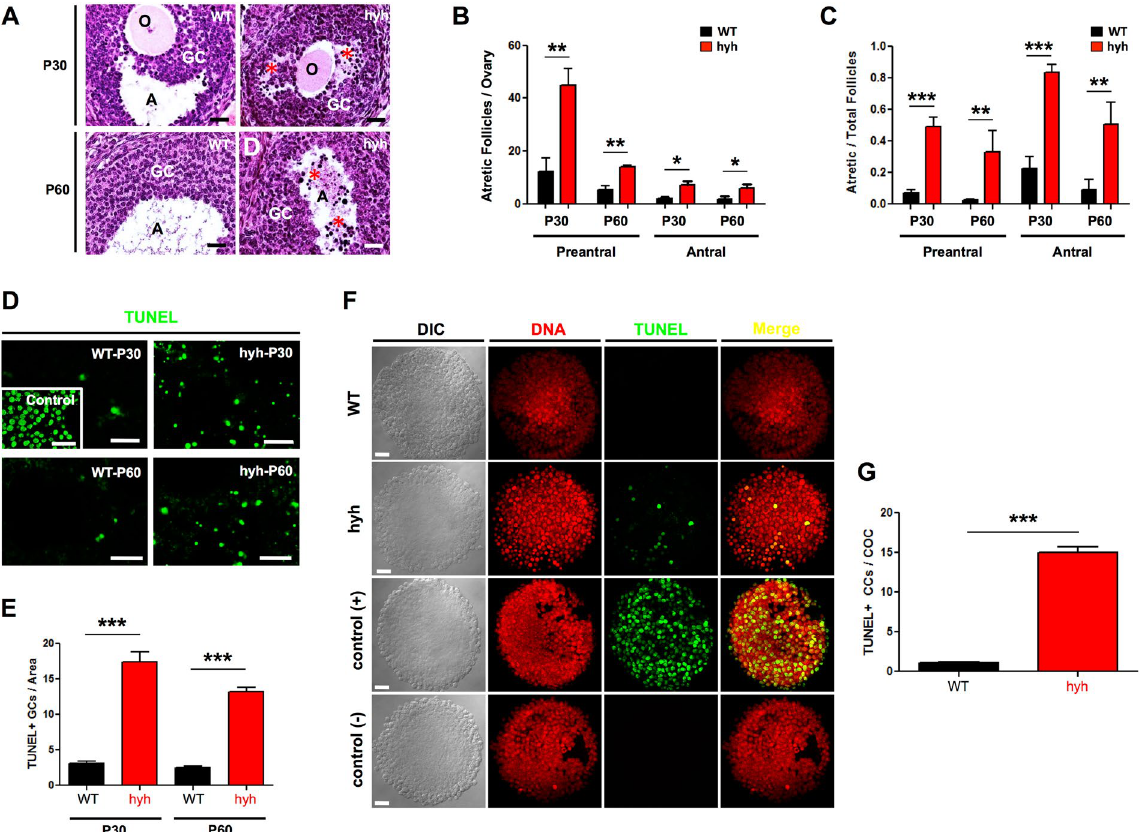
Figure 4. Follicular atresia and apoptosis of granulosa cells (GCs) in α -SNAP mutant (hyh) ovaries. ( A ) Sections of ovaries obtained from P30 and P60 WT and hyh mutant mice stained with hematoxylin-eosin. Magnifications of parts of the ovaries showing representative follicles. Atretic follicles characterized by the presence of condensed (pyknotic) nuclei (red asterisks) at the mural GC layers and in the follicular antrum ( A ) were abundant in hyh mutant ovaries. O, oocyte. Scale bars, 50 μ m. ( B ) Number of preantral and antral atretic follicles per ovary in P30 and P60 WT and hyh females. Bars represent mean ± SEM of 4 independent experiments. ( C ) Quantification of the relative number of atretic follicles among preantral and antral follicles in WT and hyh mutant mice at P30 and P60. Follicles were scored as atretic if they demonstrate at least 5% pyknotic nuclei. Bars represent mean ± SEM of 4 independent experiments. ( D ) Representative images of TUNEL assays in histological sections of WT and hyh mutant ovaries at P30 and P60. For positive controls (control), histological sections were incubated with recombinant DNase I prior to labeling procedures. Scale bars, 50 μ m. ( E ) Quantification of TUNEL + granulosa cells and bodies per area. Bars represent mean ± SEM of 3 independent experiments. ( F ) Representative images of TUNEL assays in COCs isolated from P60 WT and hyh ovaries 48 h after PMSG (10 IU) treatment. Propidium iodide was used for DNA detection (DNA). DIC, differential interference contrast microscopy. Scale bars, 20 μ m. ( G ) Quantification of TUNEL + cumulus cells (CCs) per cumulus-oocyte-complex (COC). Twenty-nine WT and 33 hyh COCs obtained from 3 WT and 3 hyh females were analyzed. Bars represent mean ± SEM. *** p < 0.001 (Student’s